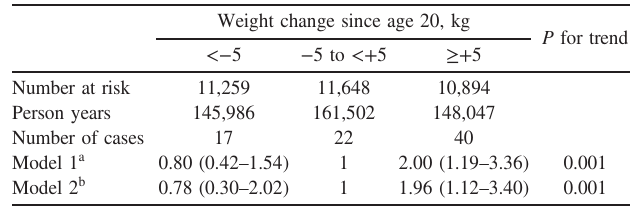
Table 3. Hazard ratios (95% con fi dence intervals) of